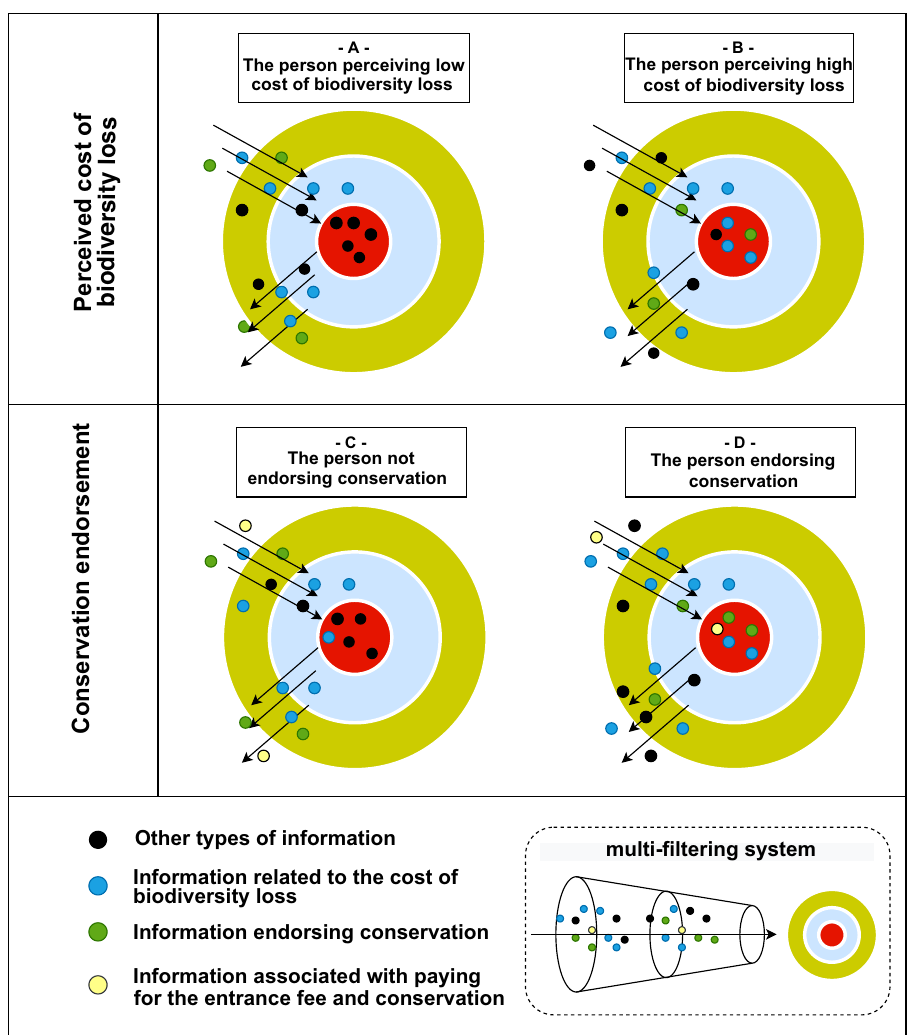
Fig. 1 The information-based psychological process leading to conservation endorsement and willingness to pay. The illustration is visualized based on information absorption and ejection processes of the mindsponge